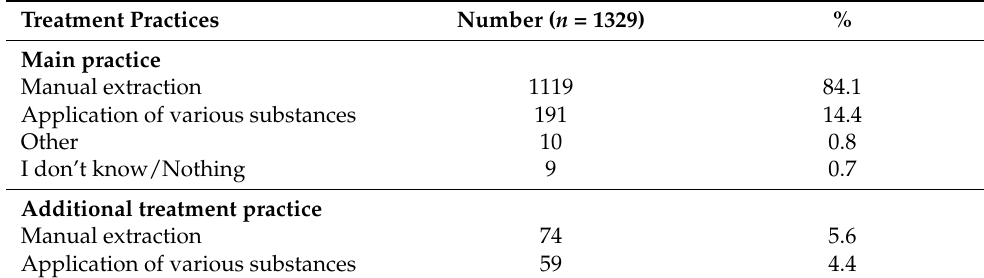
Table 5. Treatment practices for tungiasis. The question about the main practice offered several response options. The question about additional practices was answered as open-text.